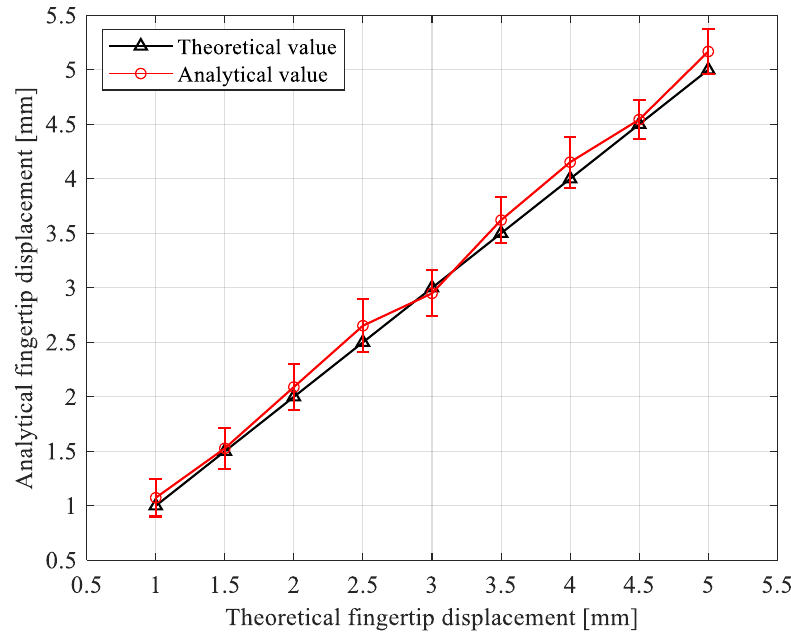
Figure 12. Analysis result for the fingertip displacements.